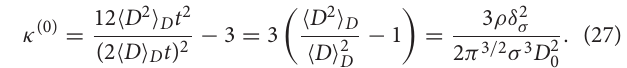
z 2 and z 4 are given by Equations (19) hh ii D hh ii D